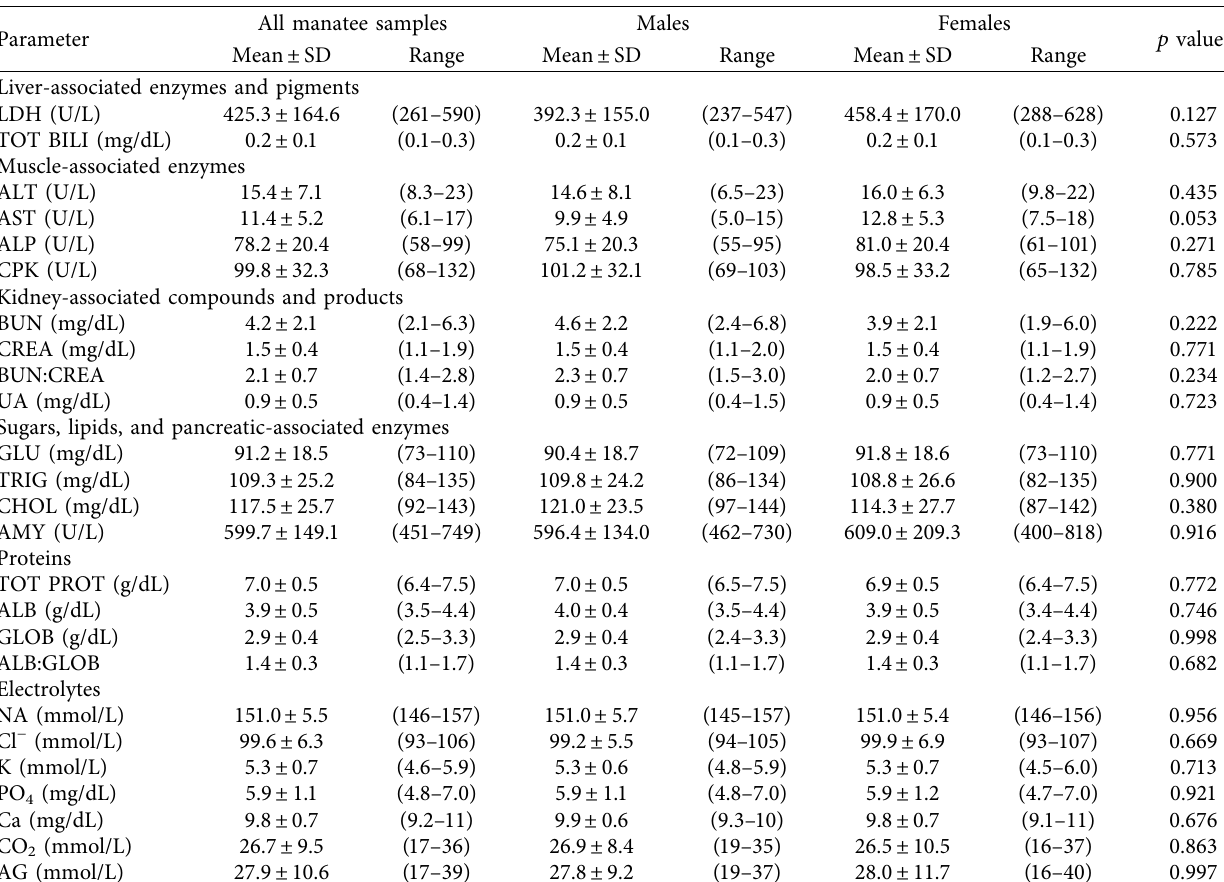
Table 5: Mean and standard deviation hematology values for Antillean manatees from Puerto Rico for all sex classes (males and females, n � 70): males only, n � 33, and females only, n � 37, with ± 1 standard deviation ranges in parentheses. Significant differences using p values are indicated with an asterisk ( ∗ ).